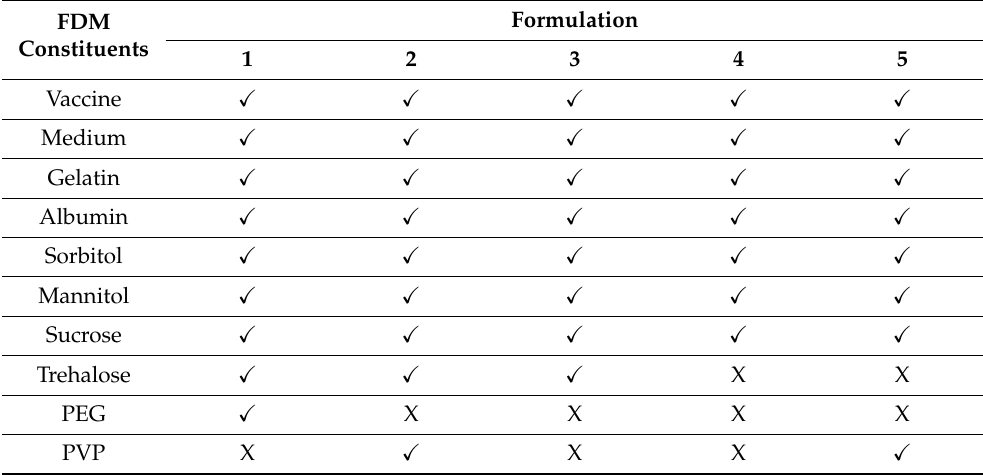
Table 1. List of excipients used in five FDM formulations ( (cid:88) -presence, X-absence). FDM